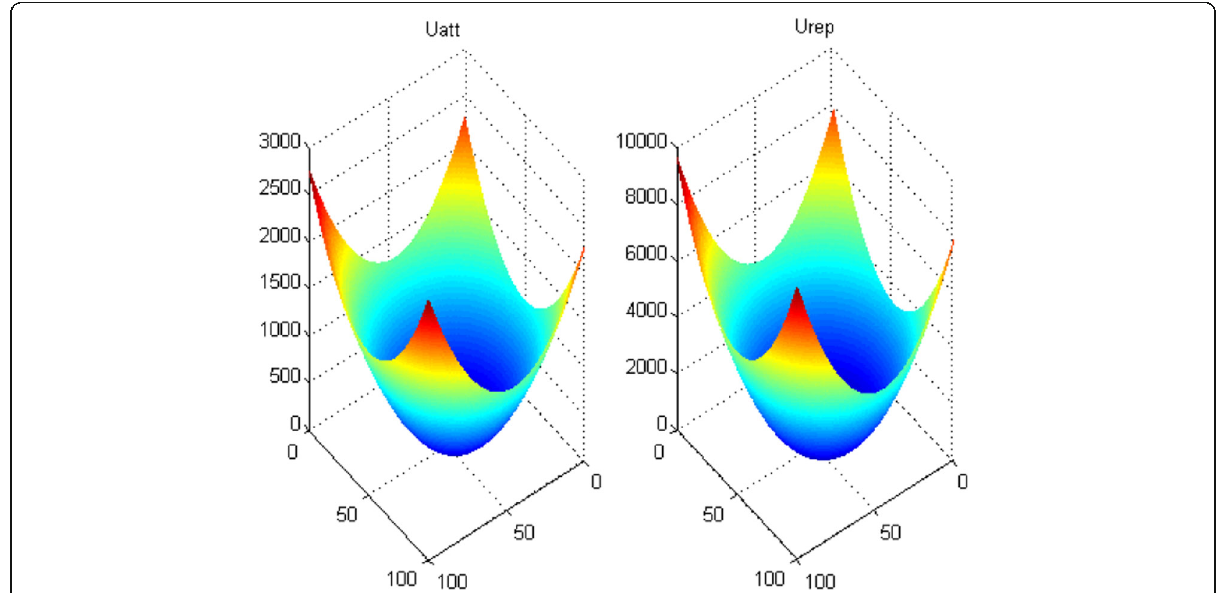
Fig. 16 Mesh plot of the potential energy of attraction and repulsion in the modified artificial potential field algorithm for circular obstacles with radius R =